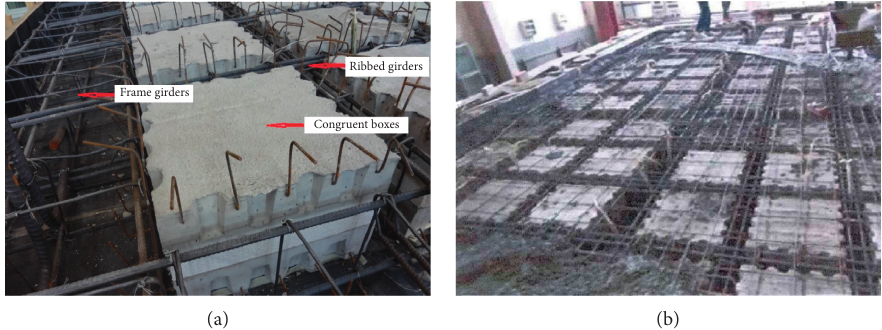
Figure 1: View of the continuous AMH slabs. (a) Structural skeleton; (b) concrete